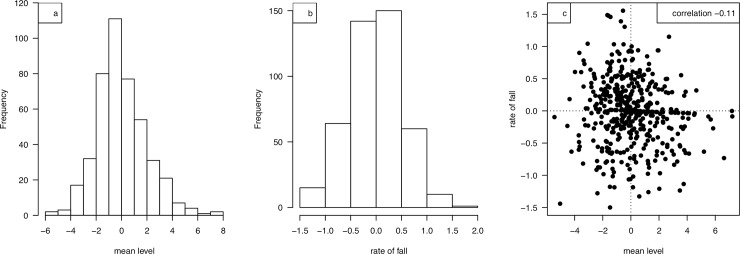
Histograms of the SITAR random effects (a) mean level and (b) rate of fall, and (c) scatterplot of rate of fall versus mean level.